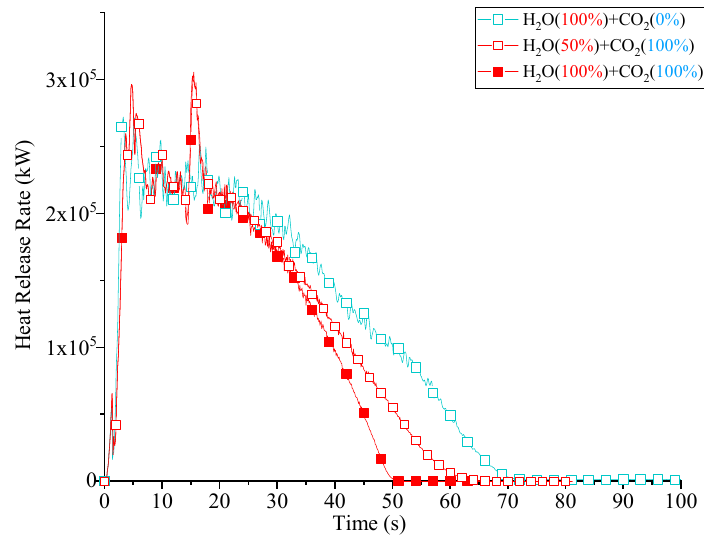
Figure 10. Comparison of the heat release rate of pool fire with the interaction of two different suppressing agents with variable concentrations. Droplet diameter = 275 µm, DPS = 1 × 10 4 , EC = 10.